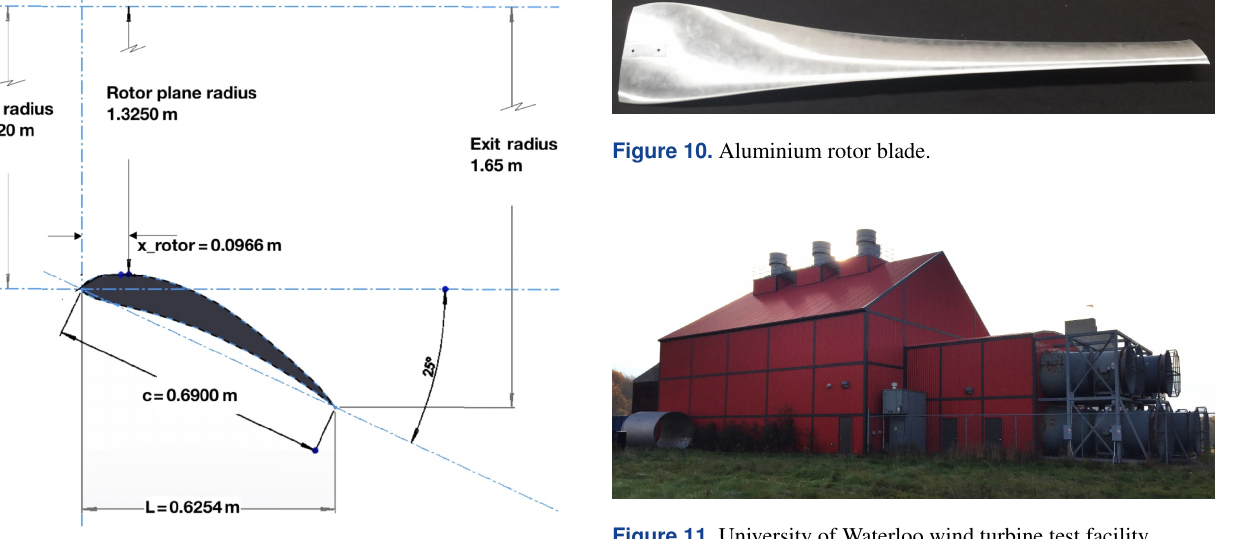
Figure 8. Duct cross-sectional geometry.